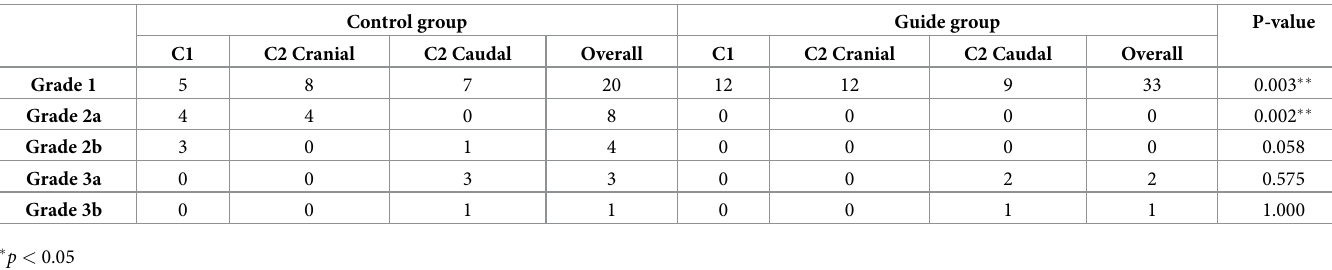
Table 2. Degrees of the vertebral canal penetration (modified Zdichavsky